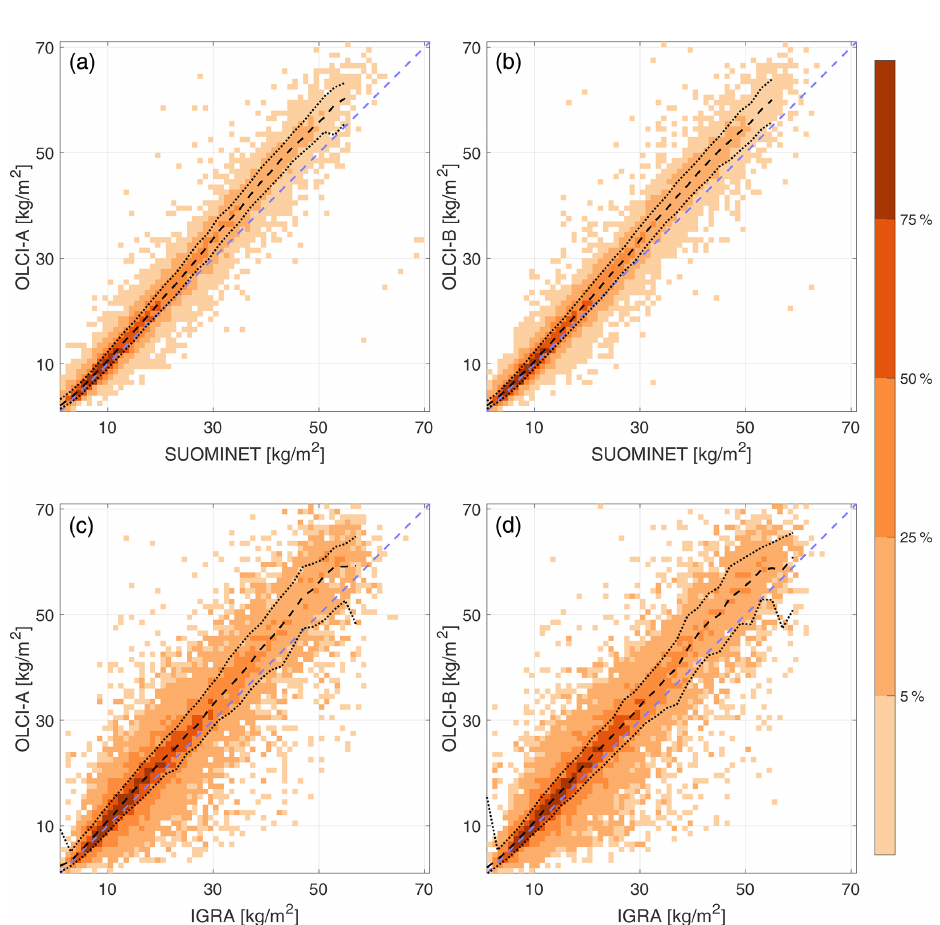
Figure 2. Density scatter plot of LAND comparisons of OLCI-A (a, c) and OLCI-B (b, d) against SuomiNet (a, b) and IGRA (c, d) observations, with CLOUD_MARGIN and CLOUD_AMBIGUOUS matchups removed. The colour field shows the percentage of matchups in each category, with the darkest colours showing the highest density of matchups. The blue dashed line shows the x = y line and the black lines show the median (dashed) and 16th and 84th percentile (dotted) OLCI-A observations for each 2kgm − 2 bin of reference observations. Linear fits of the matchups (not shown) for SuomiNet are y = 1 . 12 x − 0 . 31 (OLCI-A) and y = 1 . 11 x − 0 . 29 (OLCI-B) and for IGRA y = 1 . 07 x + 0 . 69 (OLCI-A) and y = 1 . 07 x + 0 . 64 (OLCI-B). Correlation coefficients are 0.98 (SuomiNet) and 0.90 (IGRA) for both